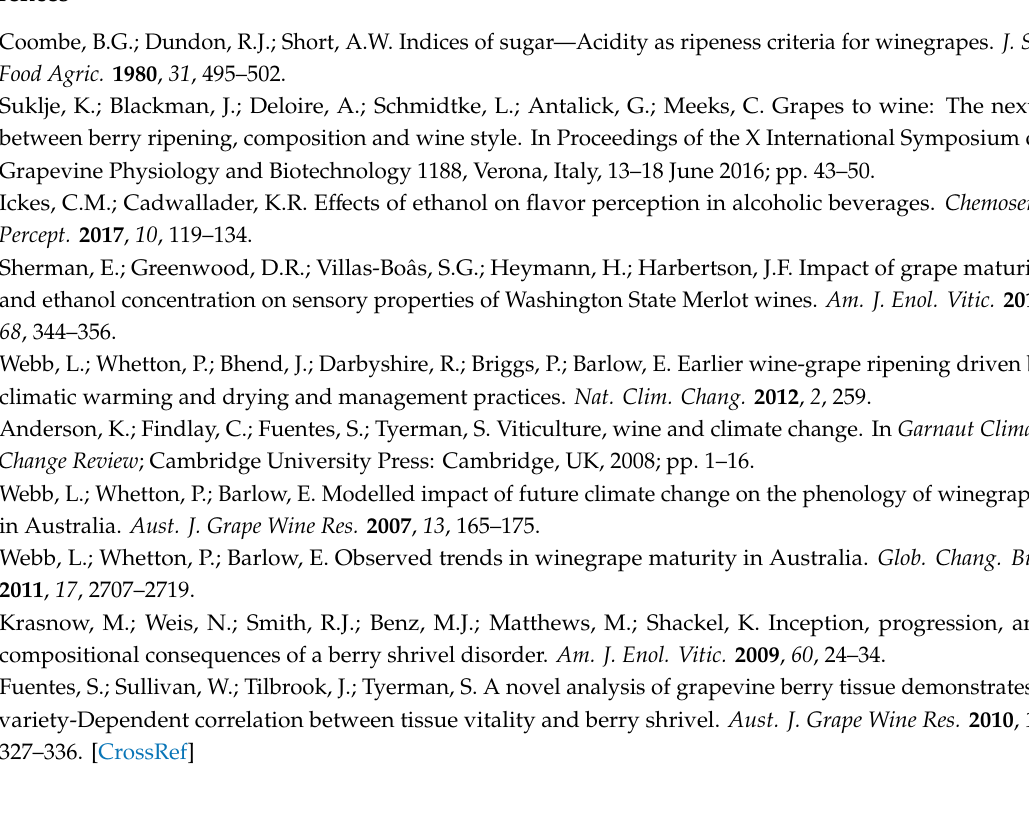
Table S1: Means and standard error (SE) of the volatile aromatic compounds and physicochemical parameters of the wined from each